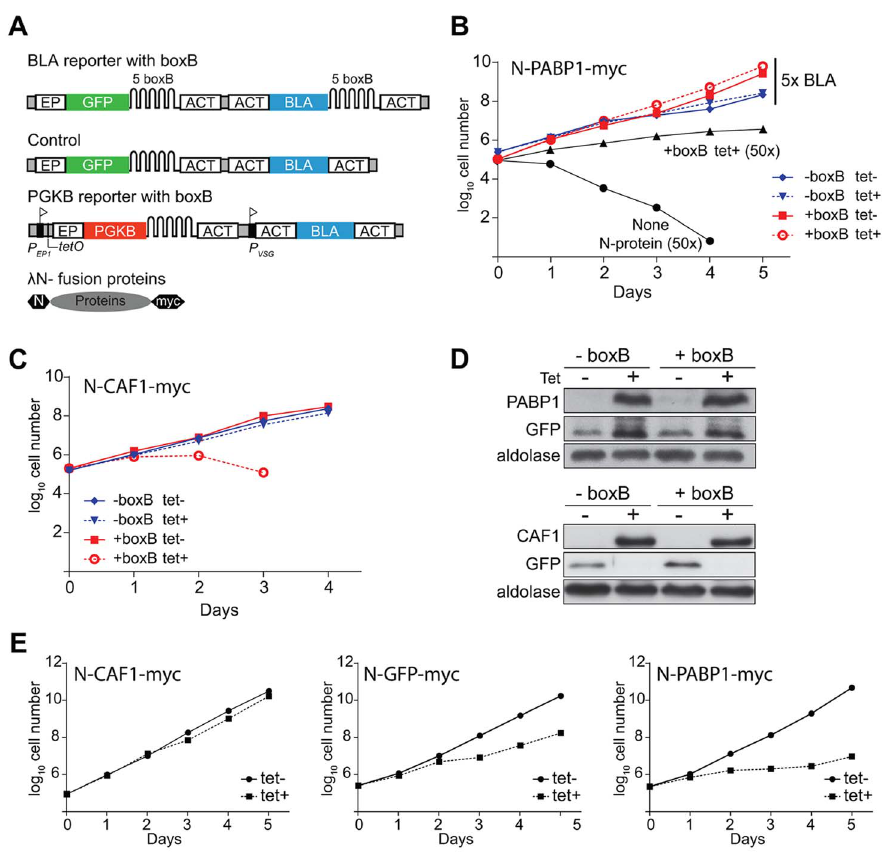
Figure 1. Proof of concept of the tethering approach. ( A ) Schematic diagram of reporter mRNAs and tethered proteins, not to scale. Above: BLA and GFP reporter mRNA with five boxB recognition sites in the 3 9 -UTR. Middle: Control BLA 3 9 -UTR mRNA without boxB. Below: PGKB mRNA with boxB recognition sites at the 3 9 -UTR. A tetracycline-inducible EP1 procyclin promoter (flag) drives PGKB expression. The downstream promoter, P VSG , gives constitutive expression of the resistance marker. Bottom: Fusion protein with N-terminal lambda-N peptide and C-terminal myc tag. ( B ) Cumulative growth curves of cells expressing the BLA reporters with tetracycline-inducible lambda-N-PABP1, in the presence of 5x blasticidin (25 m g/ ml) with or without tetracycline. For comparison, cells expressing lambda-N-PABP1 and non-transfected cells (without N-protein, parental cell line) grown in 50x blasticidin (250 m g/ml) are shown. The + boxB cells with lambda-N-PABP express a little of the lambda-N fusion even in the absence of tetracycline (panel D), which may result in slightly better growth in the presence of 25 m g/ml blasticidin. ( C ) Cumulative growth of cells containing the BLA-boxB reporter expressing N-CAF1-myc in the presence or absence of tetracycline and 5x blasticidin. ( D ) Western blot analysis of N-PABP1- myc, N-CAF1-myc and N-GFP proteins. Expression of PABP1-myc and CAF1-myc was detected with anti-myc, using aldolase as loading control. ( E ) Effect of tethered PABP1, GFP and CAF1 on growth after tetracycline-mediated induction of both PGKB and tethered protein expression.